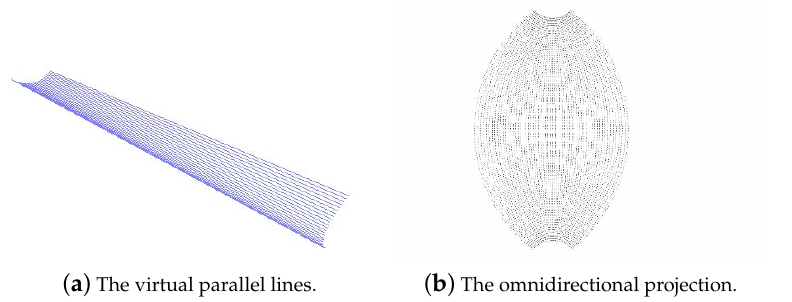
Figure 6. The parallel lines generated using the polar coordinate system and captured by an omnidi- rectional camera.